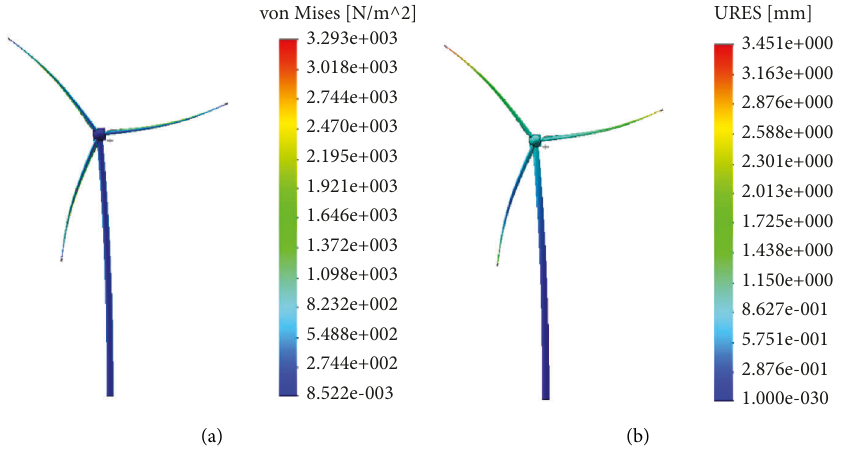
Figure 8: . Dynamic response of 4428N. (a) Stress and (b) combined displacement.